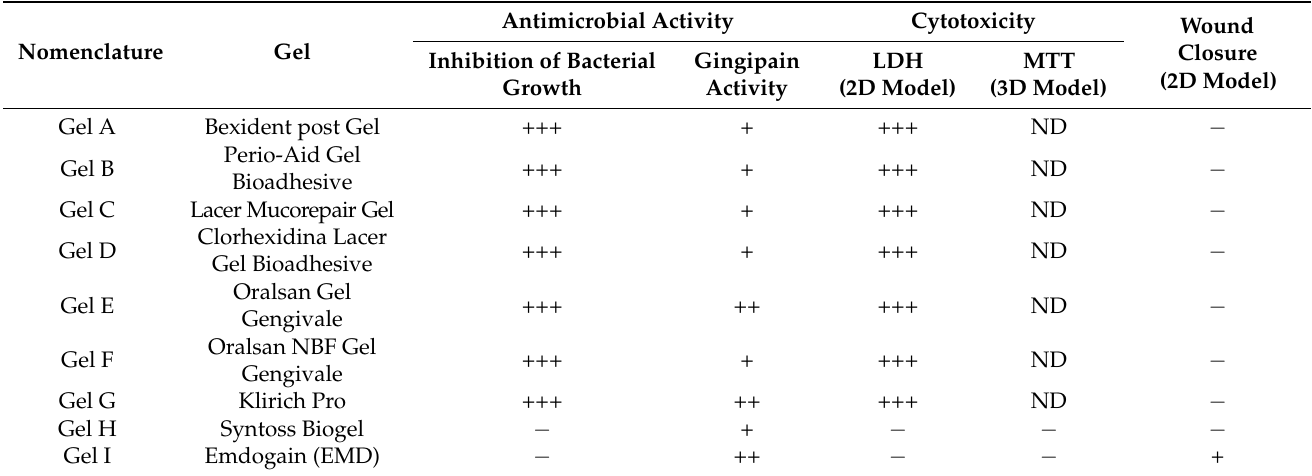
Table 4. In vitro results of the commercial gels obtained in this study. (+++) High effect, (++) Moderate effect, (+) Low effect, ( − ) Null effect and (ND) No